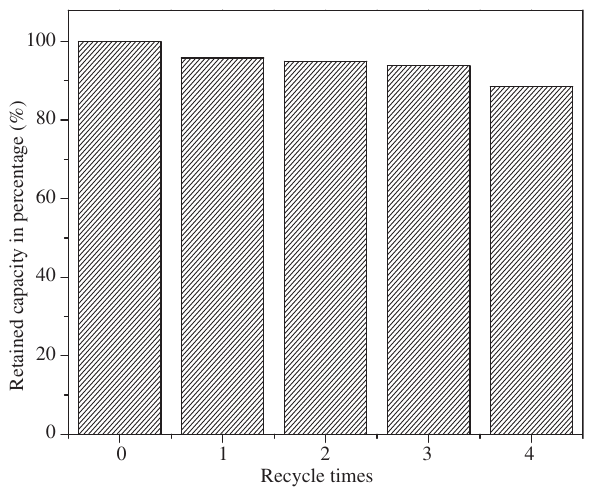
O /C-CAA micro- 3 4